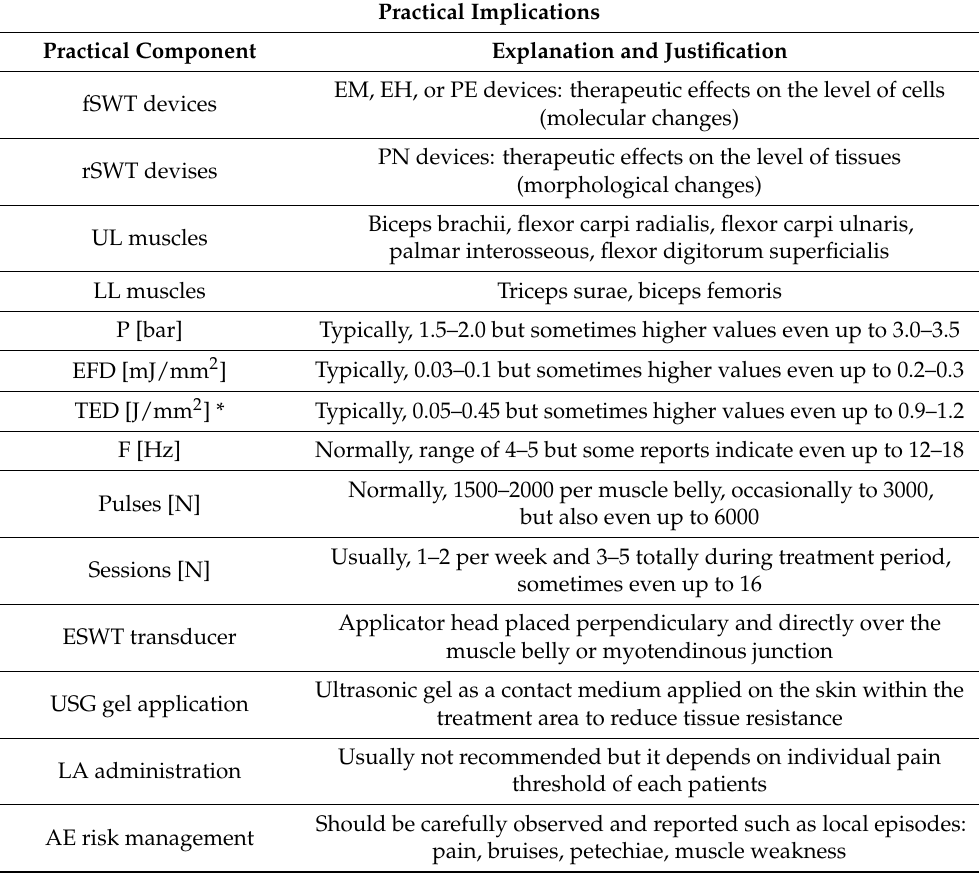
Table 7. Implications for clinical practice in using ESWT for post-stroke spasticity management. Practical